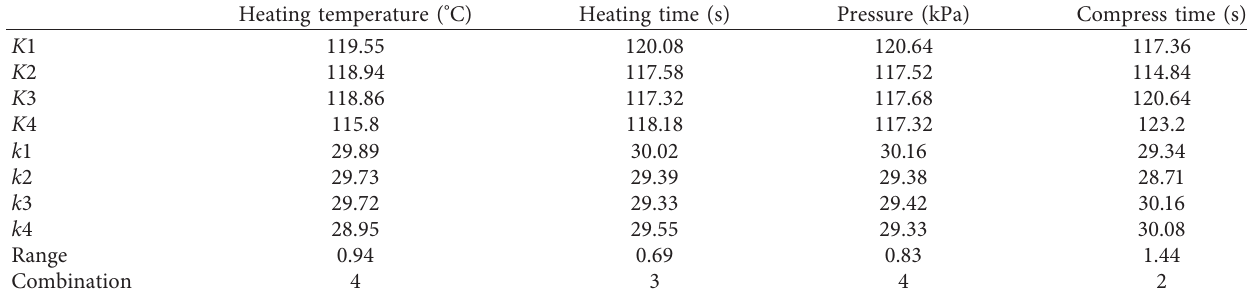
Table 3: Influence of various factors on the maximum thinning rate.